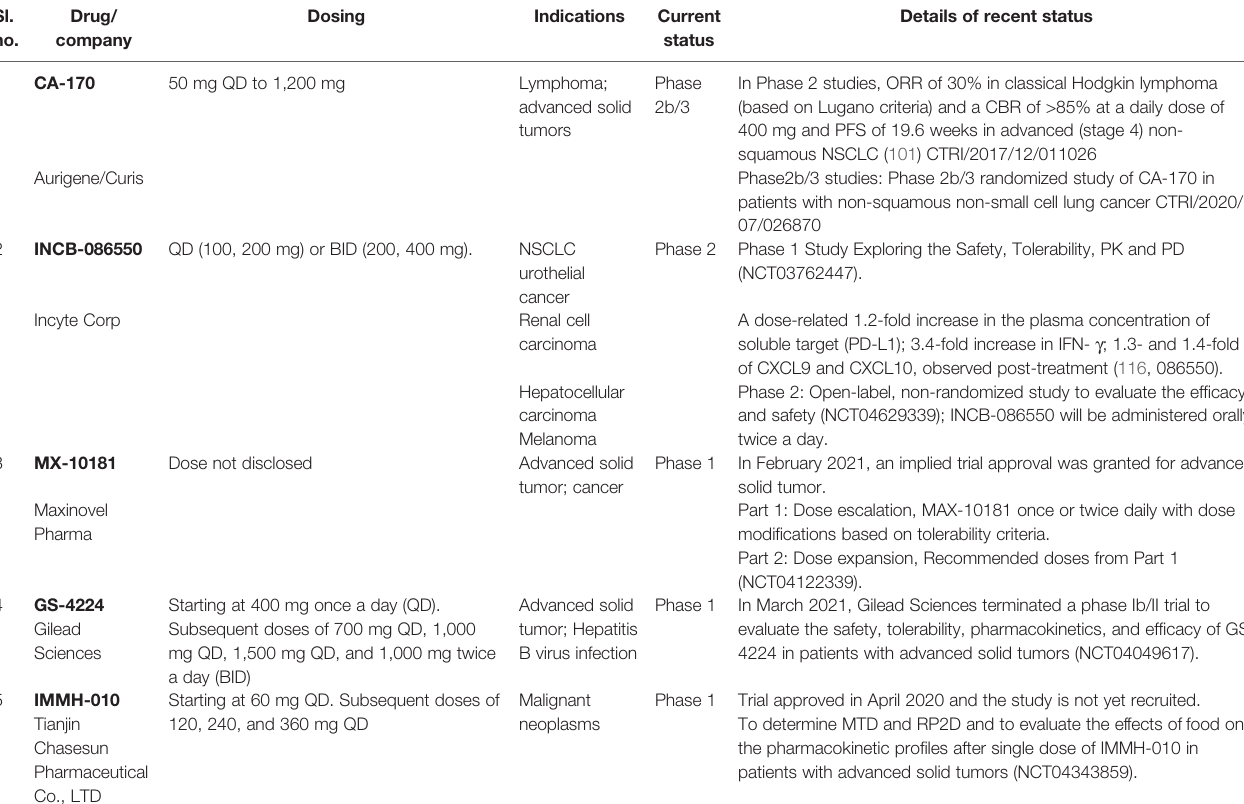
TABLE 3 | Details of small molecules in clinical trials. Sl.